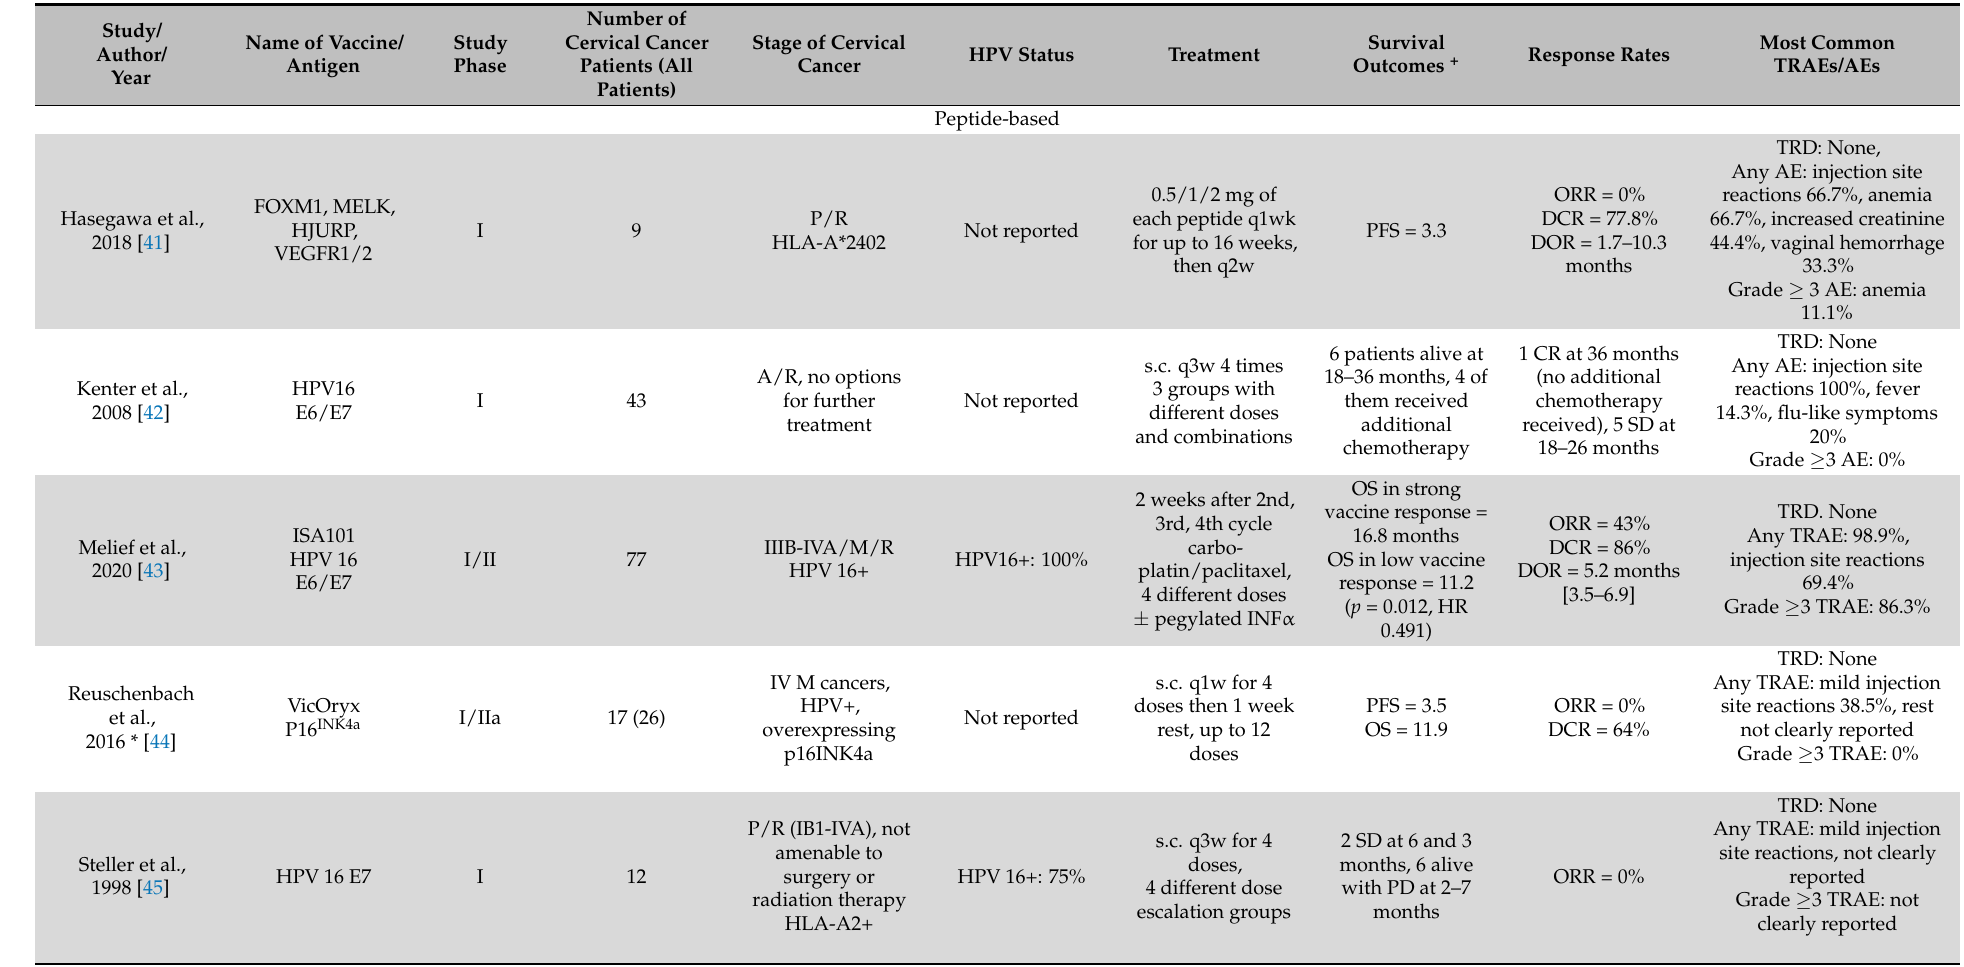
Table 3. Overview and results of clinical trials assessing therapeutic vaccines in cervical cancer